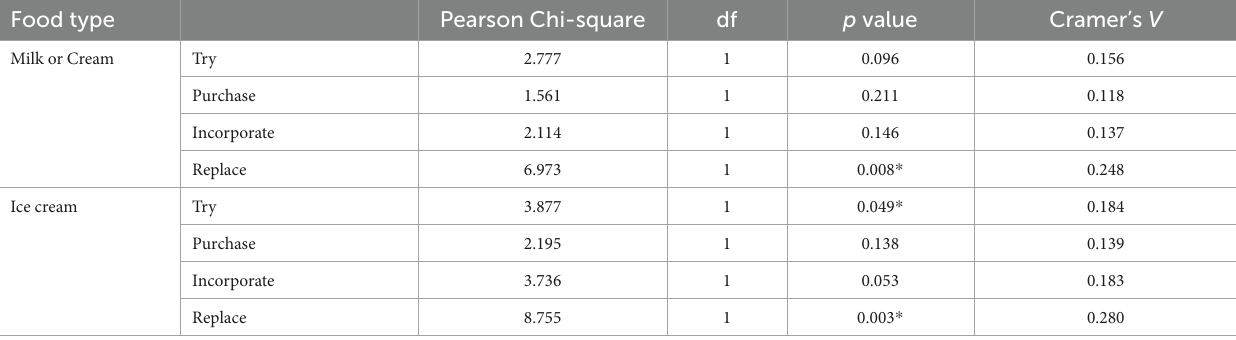
TABLE A1 Chi-Square test statistics examining differences in responses between vegans and non-vegans for likelihood to try, incorporate and replace milk or cream and ice cream with yeast-derived dairy alternatives.